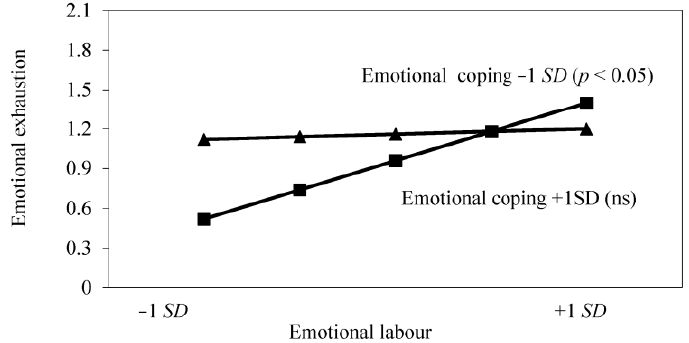
Figure 2. Interaction effect of emotional labour and emotional-focused coping on emotional exhaustion.